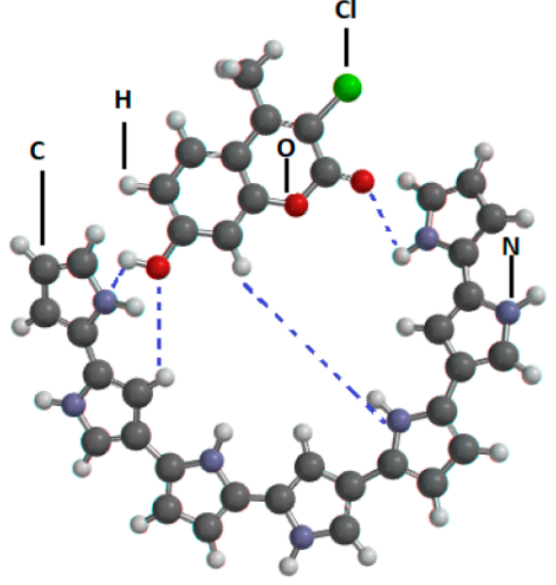
Figure 5. Representation of the CFN ‐ Polypyrrole interaction during electro ‐ polymerisation. (N = Representation of the CFN-Polypyrrole interaction during electro-polymerisation.